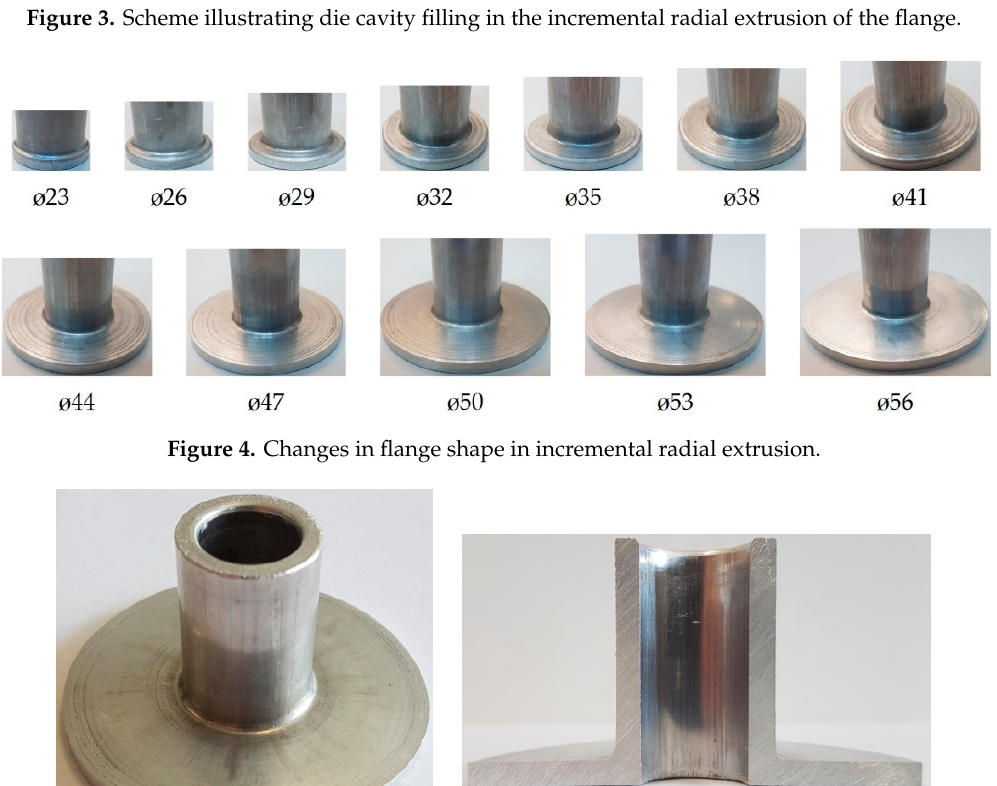
( c ) Figure 6. Hollow part with a flange produced by ( a ) incremental radial extrusion—crack formation, ( b ) incremental radial extrusion—visible crack, ( c ) radial extrusion without rings—visible crack. The initiation of cracking can be predicted using one of the available fracture criteria. One of them is the Cockcroft–Latham ductile fracture criterion that is expressed by: (cid:3505) (cid:2026) (cid:3040)(cid:3028)(cid:3051) (cid:2026) (cid:3009)(cid:3014)(cid:3009) (cid:1856)(cid:2013) = (cid:1829) (2) where σ max is the maximum principal stress, σ HMH is the reduced stress according to the Huber–Mises–Hencky hypothesis, ε is the strain, C is the material constant. It is assumed that the higher the value of C is, the higher the probability of cracking becomes. Figure 7 shows the distribution of the normalized Cockcroft–Latham ductile fracture criterion. It can be observed that the highest values are located on the flange rim. The value of the criterion increases with increasing the flange diameter; for a 56 mm diameter flange, it is equal to 1.08, which—as the experiments prove—is a safe value. When the material begins to lose coherence, both the maximum value of the Cockcroft–Latham criterion and the maximum circumferential stresses are located on the flange rim (Figure 8). The limit value of this criterion is about 1.15, while the